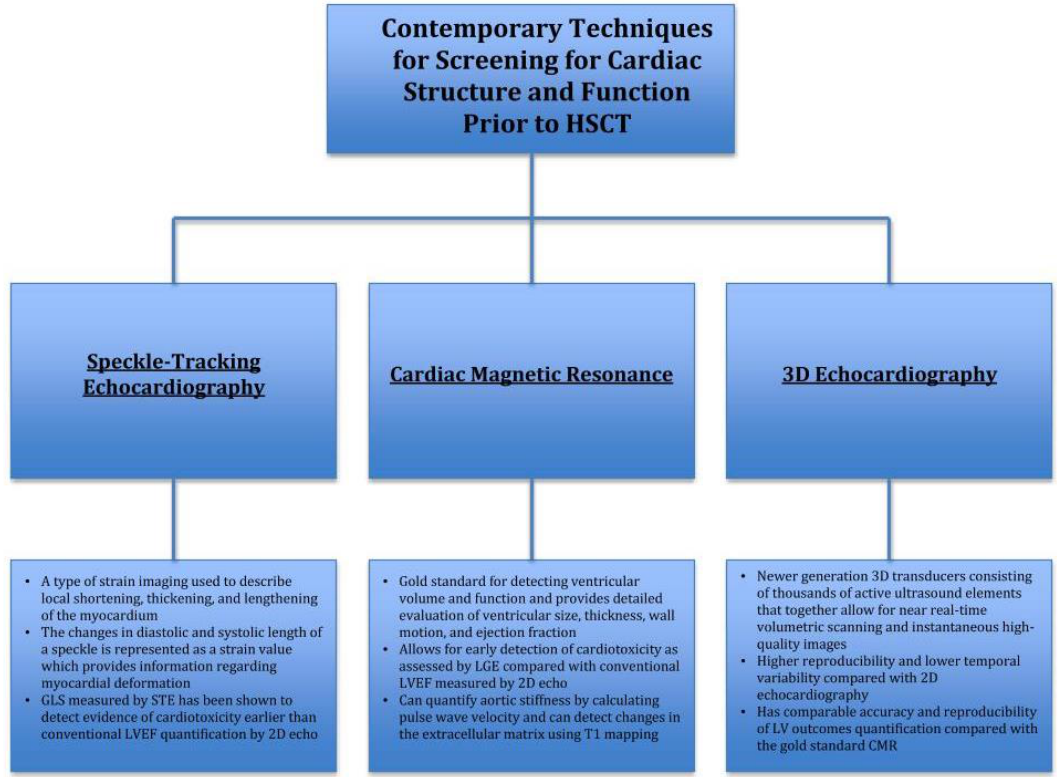
Figure 1. Screening for cardiac structure and function prior to hematopoietic stem cell transplant (HSCT). STE, speckle-tracking echocardiography; GLS, global longitudinal strain; LVEF, left ventricular ejection fraction; LGE, late gadolinium enhancement; LV, left ventricular; CMR, cardiac magnetic resonance; HSCT, hematopoietic stem cell transplant.